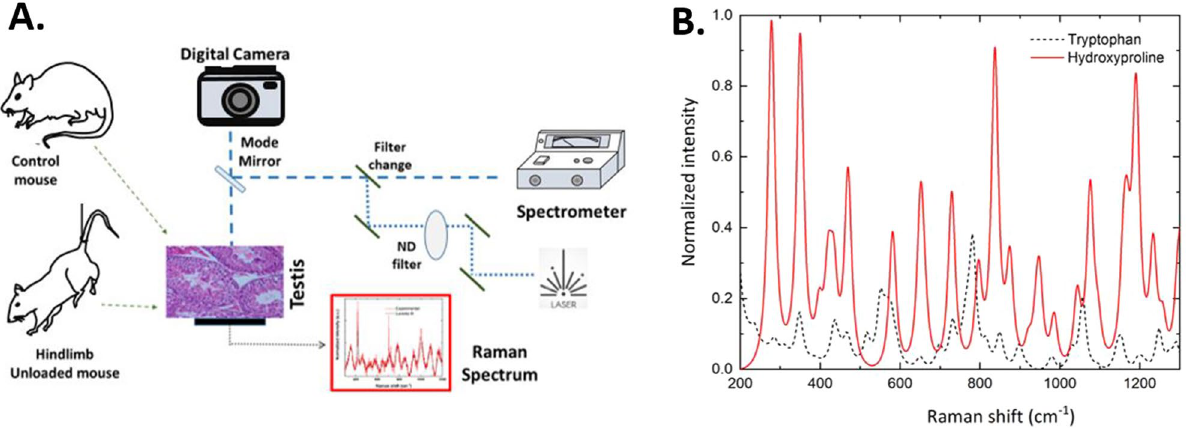
Figure 5. Schematic representation of the experimental procedure for collecting Raman spectroscopic data ( A ) and the calculated Raman spectra for tryptophan and hydroxyproline molecules and their average spectra ( B ) from the experimental